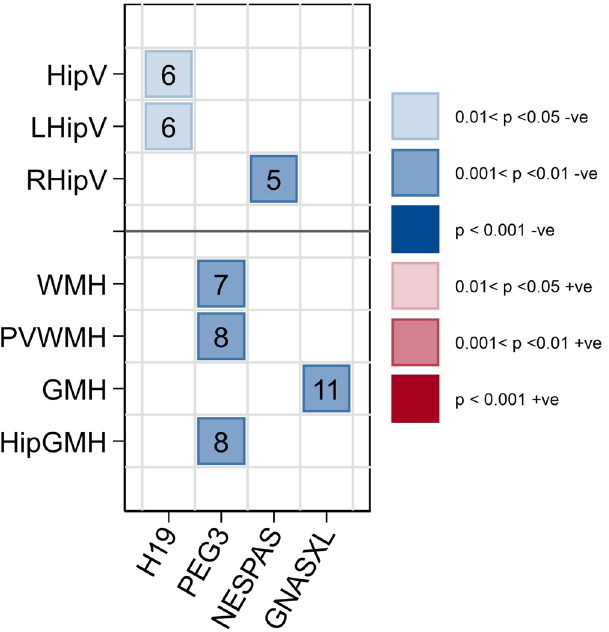
Figure 3. Heatmap showing significant blocks of association between imprint methylation and hippocampal volumes (in mm 3 ) and hyperintensities at baseline MRI imaging following permutation analysis in ABC36 participants (HipV = hippocampal volume; LHipV = left hippocampal volume; RHipV = right hippocampal volume; WMH = white matter hyperintensities; PVWMH = periventricular hyperintensities; GMH = grey matter hyperintensities; HipGMH = grey matter hyperintensities specific to the hippocampus). Blue indicates negative associations and red positive. Colour gradients represent level of significance with most intense colour indicating the highest level of significance. Numbers of significant CpG sites in the association block are shown. Imprints are organised in chromosomal order along the x-axis. Created using STATA/MP version 15 (StataCorp. 2017. Stata Statistical Software: Release 15 . College Station, TX: StataCorp